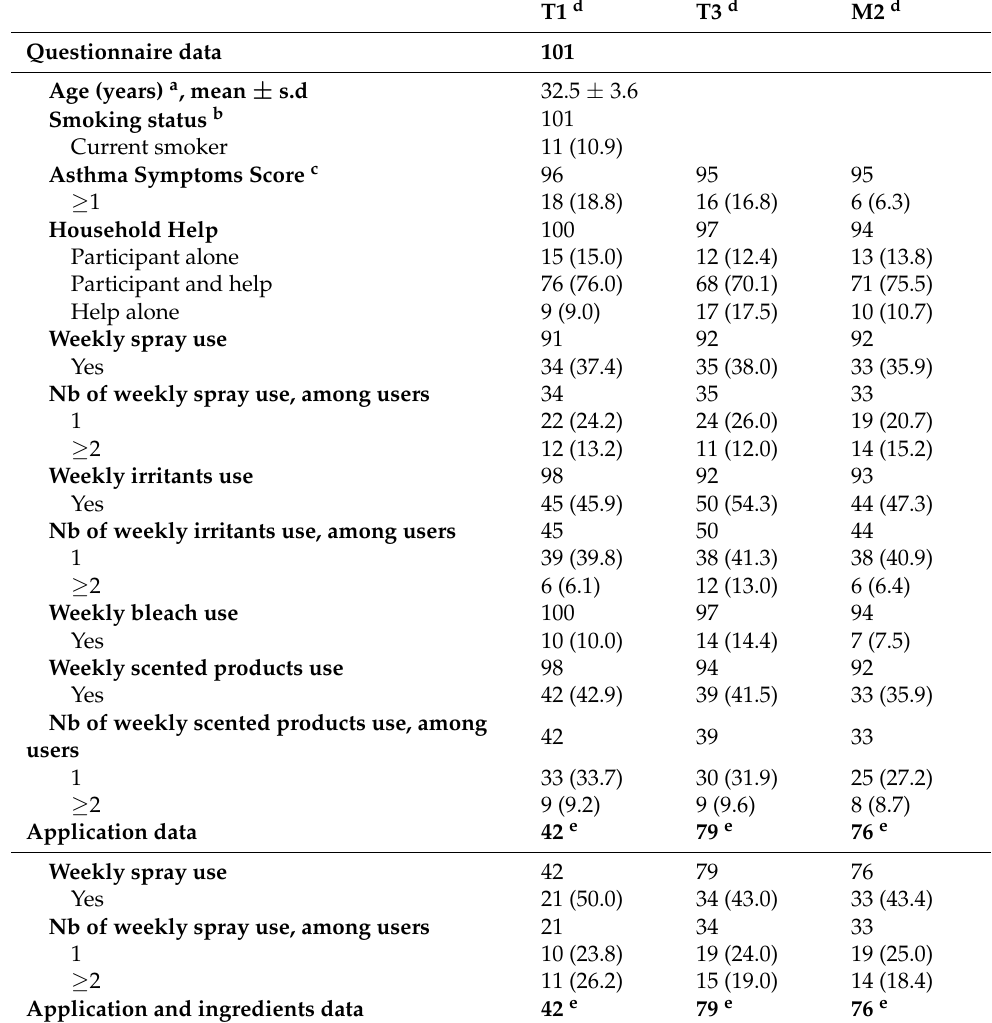
Table 1. Population characteristics according to the three data collection times in the SEPAGES